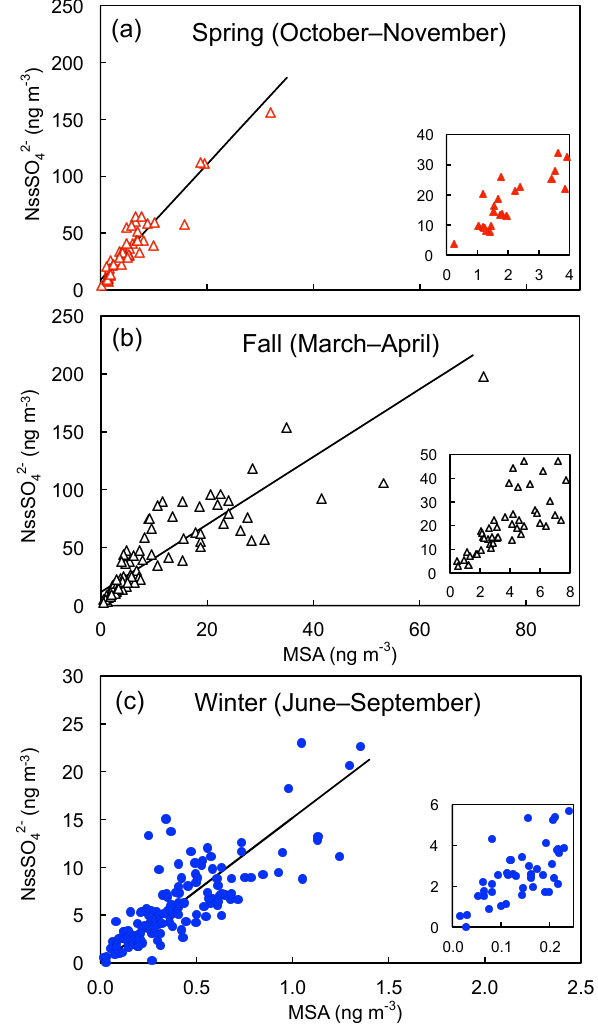
Figure 11. Correlation of nssSO 4 with MSA concentrations ob- served at Concordia on HV bulk aerosol samples collected in spring (a) , fall (b) , and winter (c) . The paneled-in figures highlight the correlation at MSA concentrations close to zero.